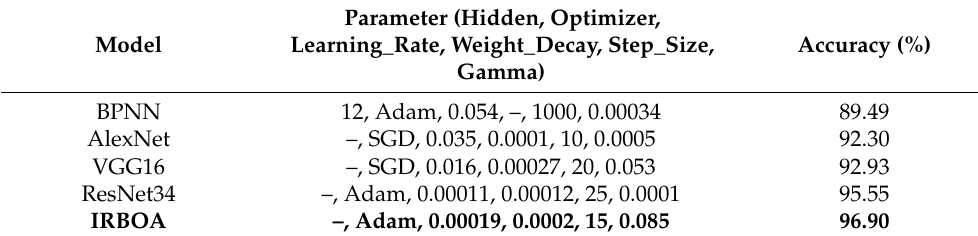
Table 3. Hyperparameter results for the five models of Bayesian optimization. Parameter (Hidden, Optimizer, Model Learning_Rate, Weight_Decay, Step_Size,